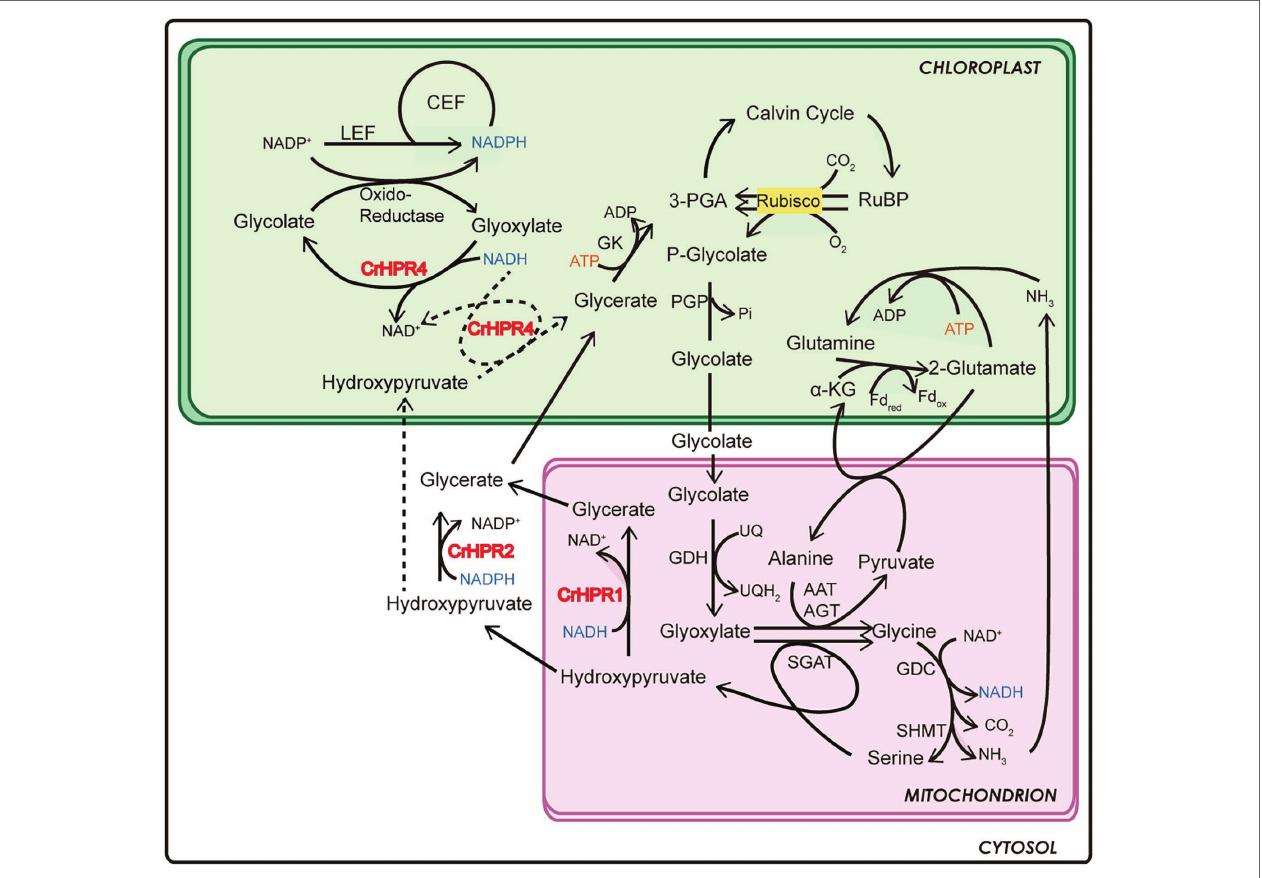
FIGURE 6 | Schematics of the functional mechanism of CrHPRs in photosynthesis and photorespiration based on this